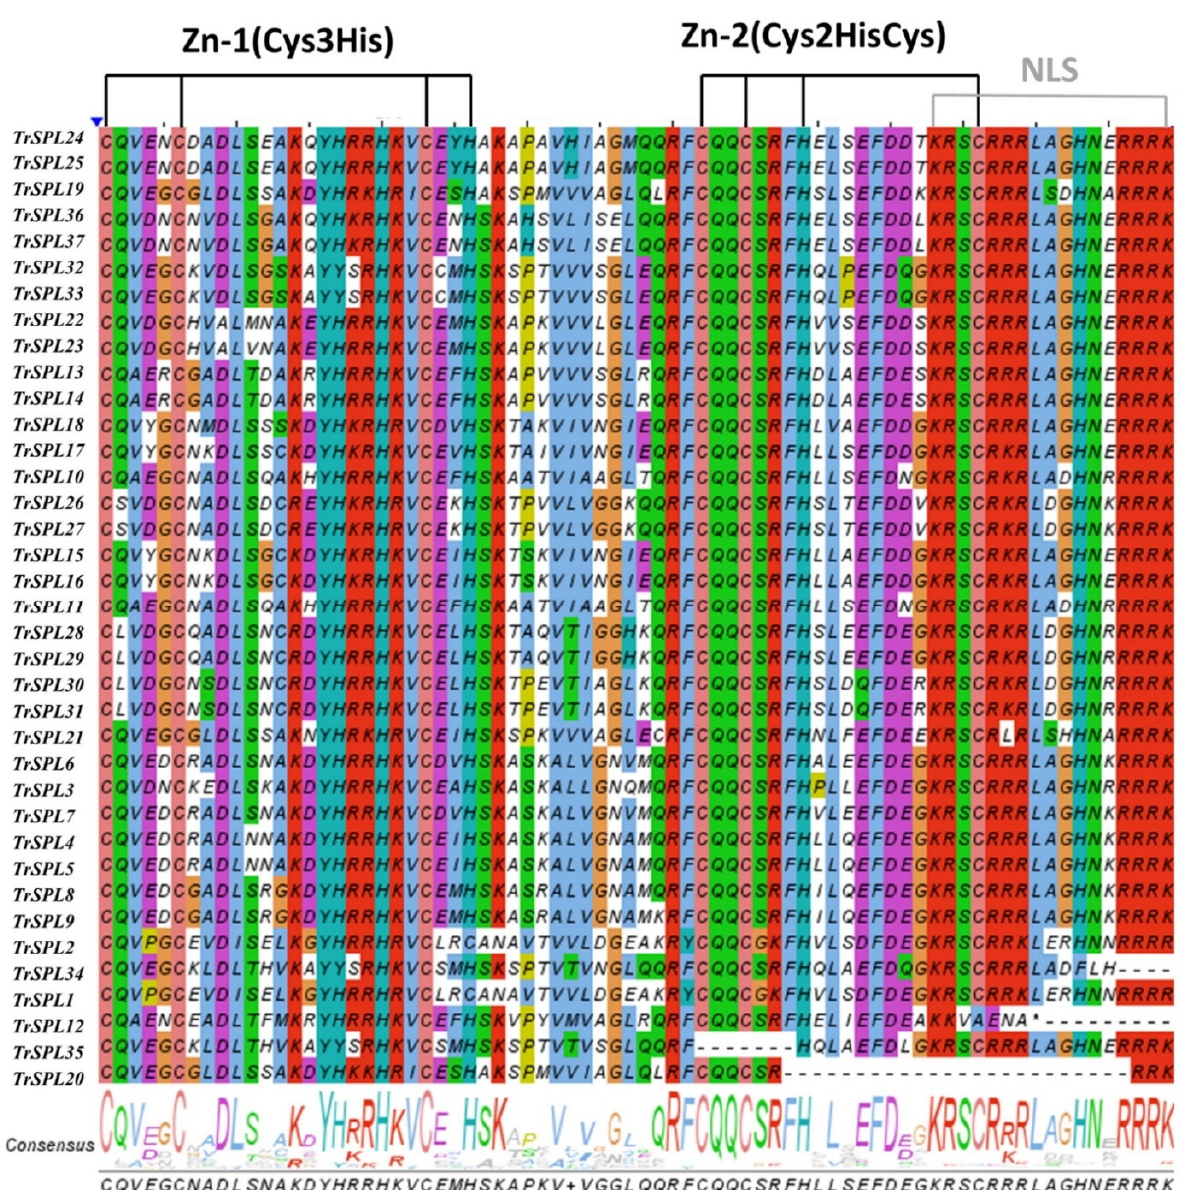
Figure 3. Sequence alignment and logo of SBP domain from T. repens . Two Zn-finger structures (Zn-1, Cys3 His; Zn-2, Cys2HisCys) and one NLS structure have been marked.